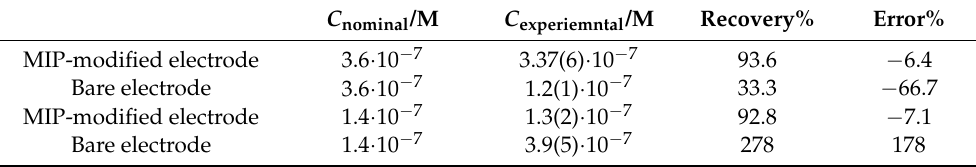
Table 8. Recovery% and Error% using SPC-bare and SPC-MIP of tap water adjusted to pH 5.5 and fortified with different concentrations of